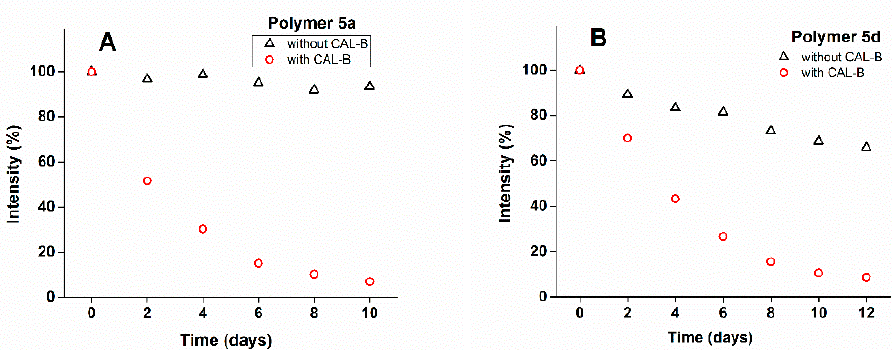
Figure 6. Intensity of emission of curcumin encapsulated in nanocarriers having pH 7.4 (1 × PBS buffer) and incubated with and without enzyme at 37 °C ( A ) 5a ; ( B ) 5d .